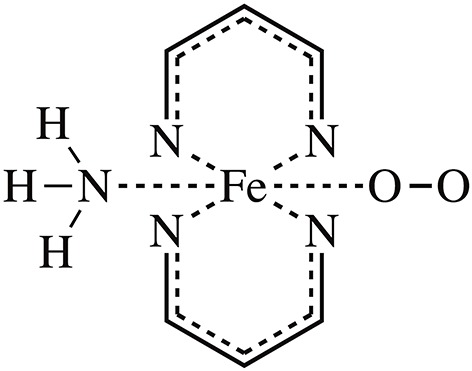
The molecular model of this work. The simplified heme model Fe2+(C3N2)2NH3 complex with O2 binding was adopted.